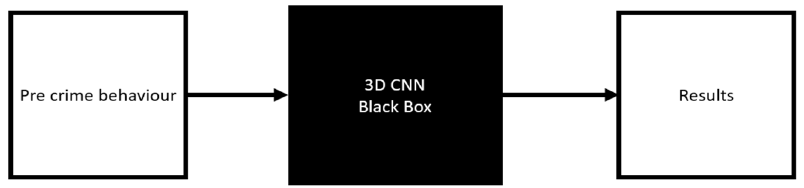
Figure 1. The black box model for shoplifting detection, where a raw video sequence is used to train a black box algorithm (such as a 3D CNN as in [6]) to detect suspicious individuals. The nature of these models makes them difficult to interpret and susceptible to bias in the training data.